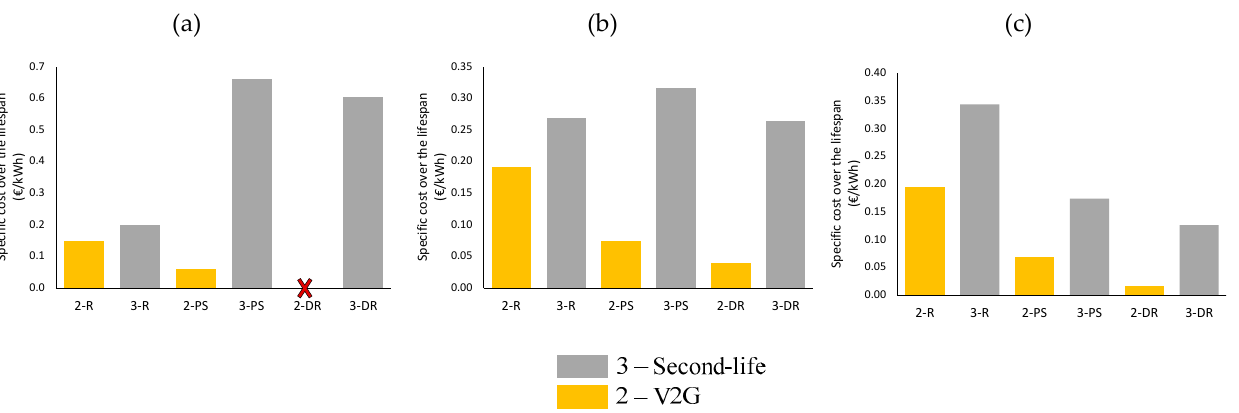
Figure 7. Specific cost over the battery lifetime, considering the provided kWh as grid services, for ( a ) 40 kWh batteries, ( b ) 70 kWh batteries, and ( c ) 90 kWh batteries.